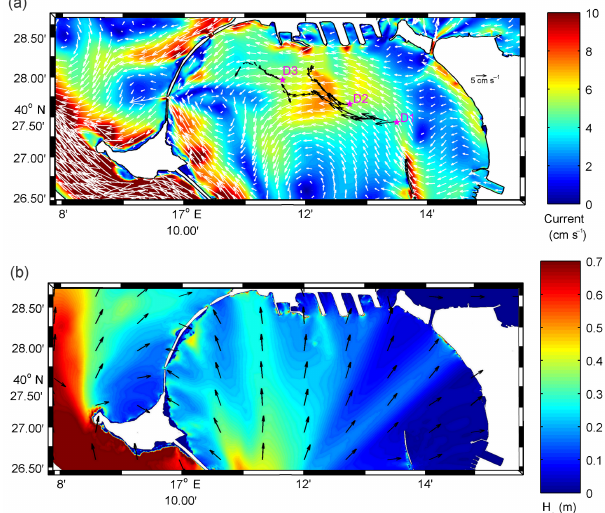
Figure 9. Numerical results from coupled TEL3D + TOM in the area of Mar Grande on 5 October 2014 (average over 10:00–12:00). (a) Surface velocity: color map for the velocity magnitude, white arrows for current directions and black arrows for drifter routes (av- erage). (b) Wave distribution: color map for the significant wave height H s and black arrows for the mean direction.